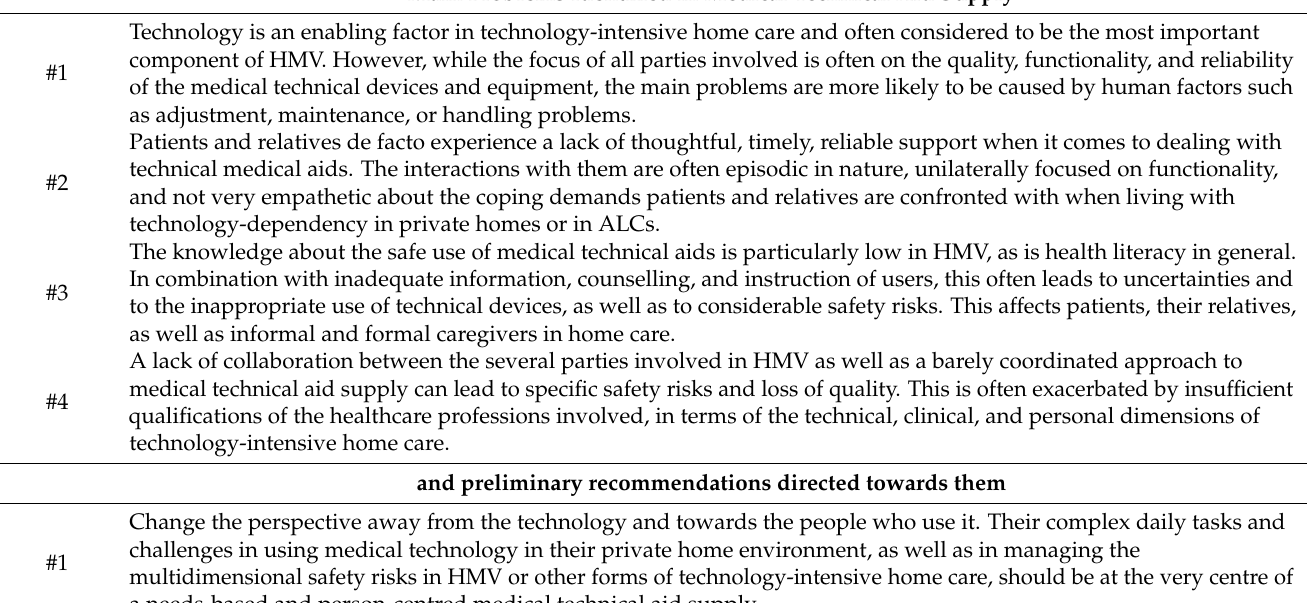
Table 4. Main problems and preliminary